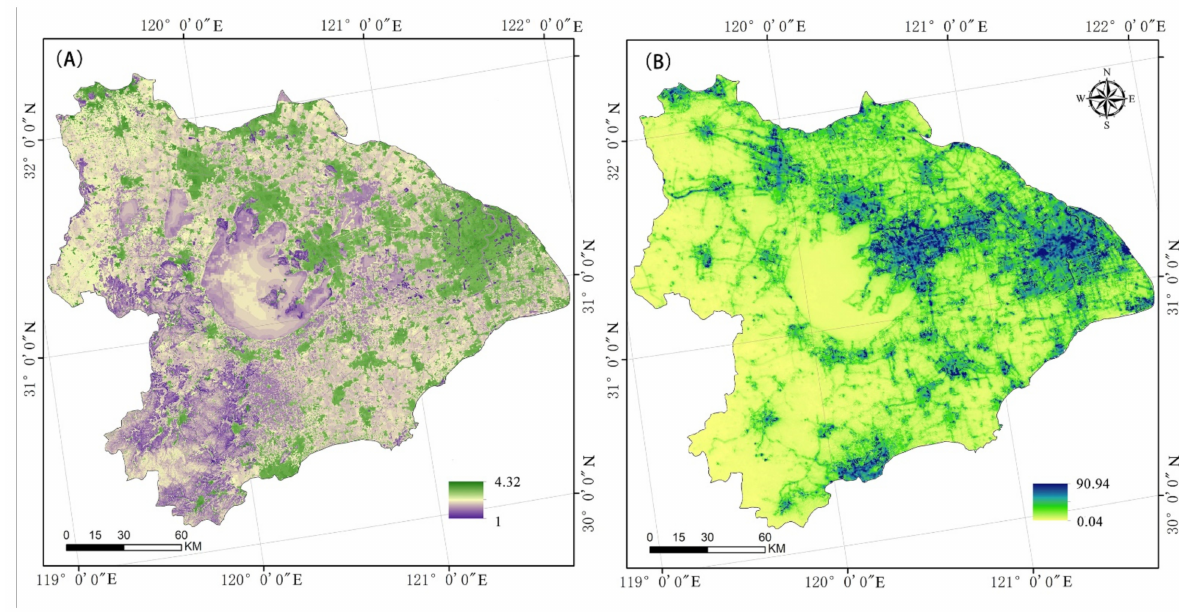
Figure 5. Resistance surface around Taihu Lake Basin: ( A ) Natural comprehensive resistance surface; and ( B ) corrected resistance